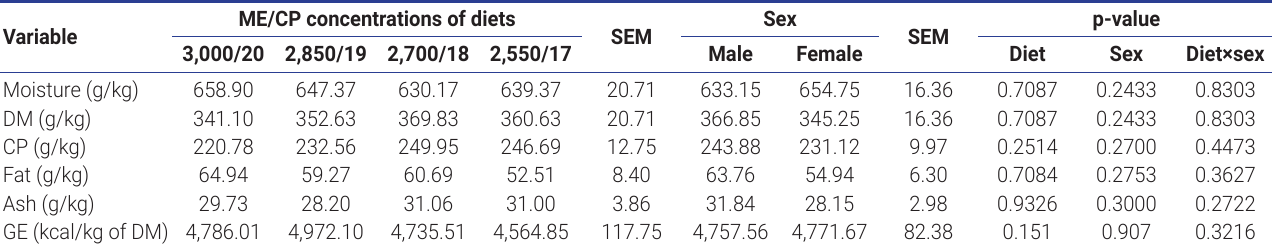
Table 5. Whole-body chemical composition of 12-week-old of Mexican Creole chickens fed diets with different concentrations of ME and CP Variable